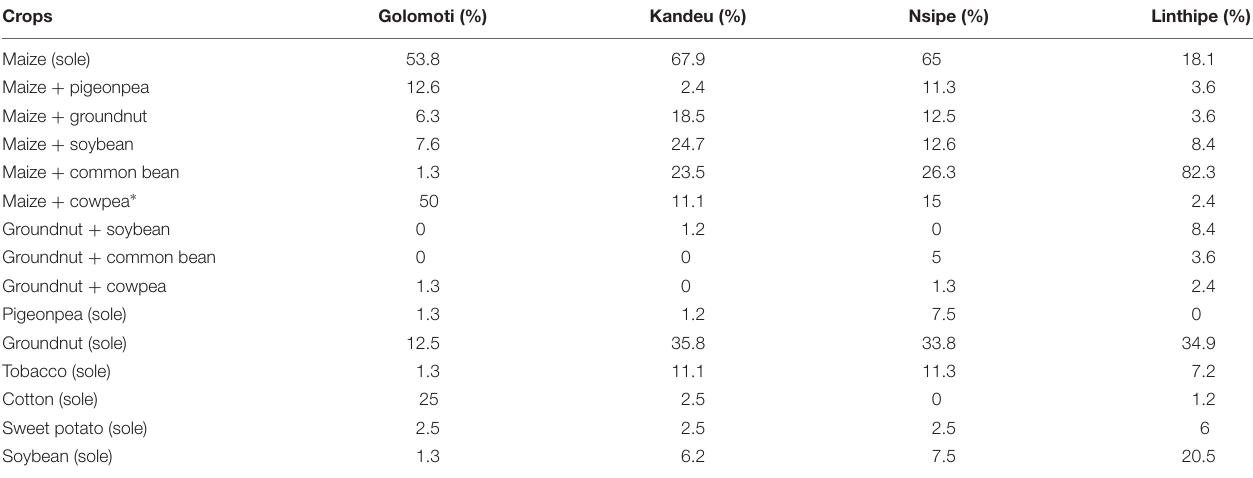
Sweet potato (sole) Soybean (sole)